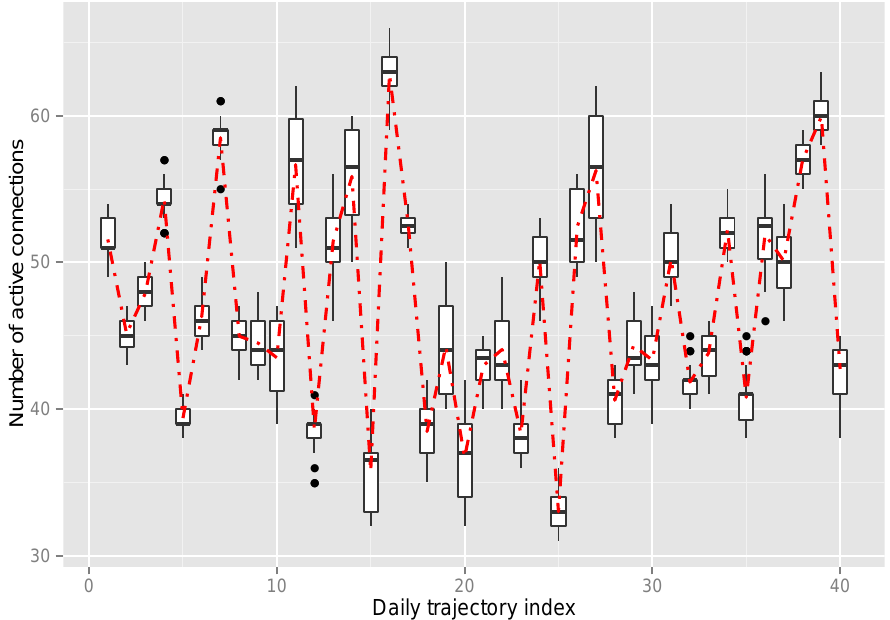
Figure 8. Evolution of the connections in 30 s of the busy period, 40 trajectories. Each boxplot shows the values for the same day, and the red dashed line shows the mean function.